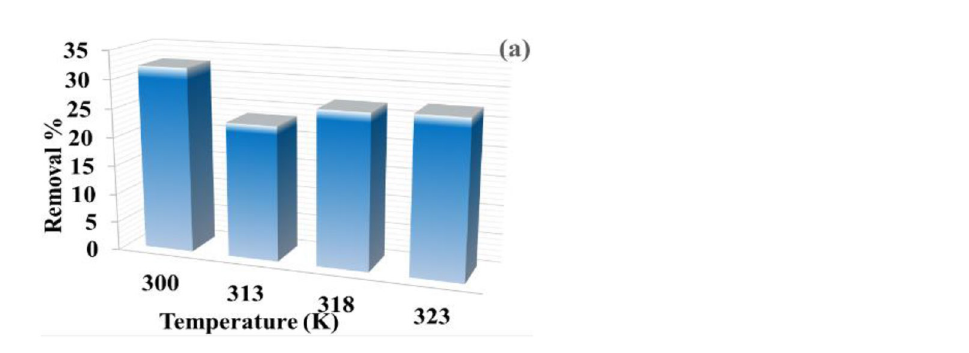
Figure 10. Temperature influence on the absorption capacity of CAH (1.5 g/L) at pH 2, DB86 dye (50 ppm) after 180